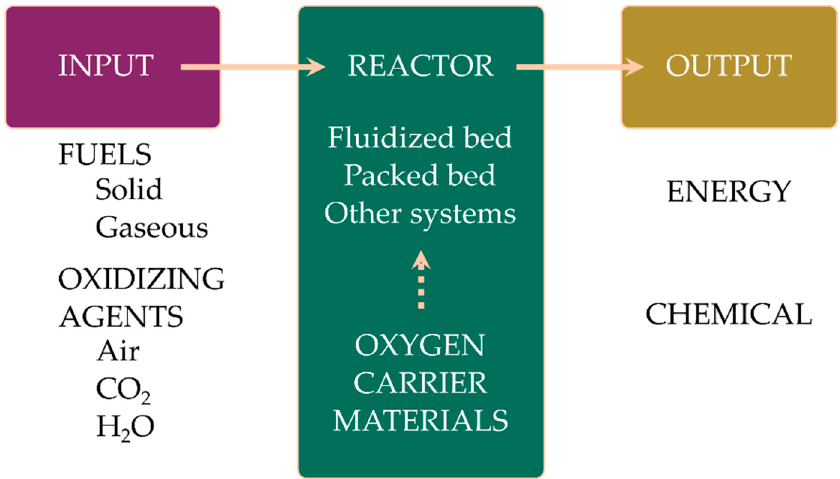
Figure 1. A general overview of the parts of the chemical looping process discussed in this review.